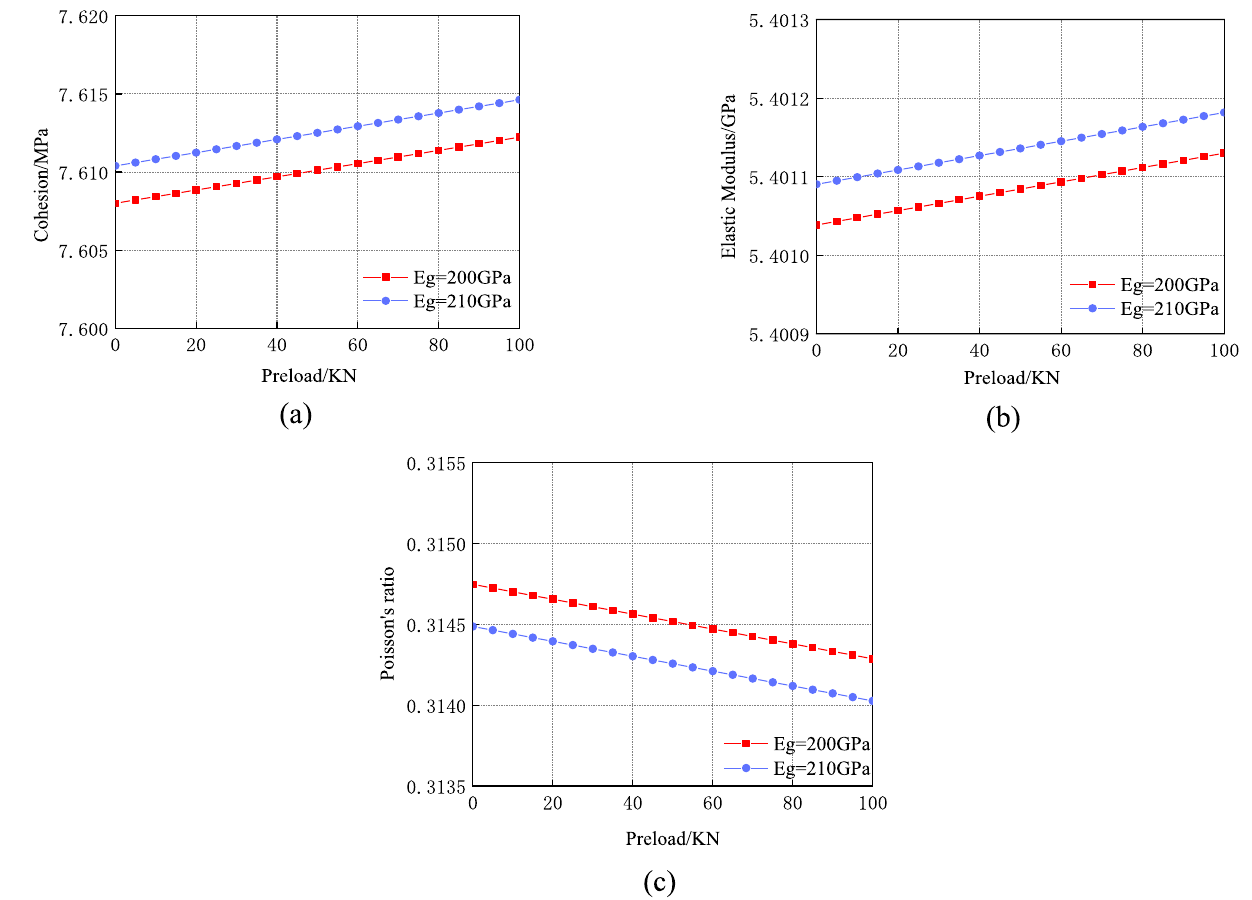
Figure 13. Influence of pre-tightening force and elastic modulus of anchor on physical and mechanical parameters of surrounding rock reinforcement body: ( a ) Influence on cohesion; ( b ) Influence on elastic modulus; ( c ) Influence on Poisson’s